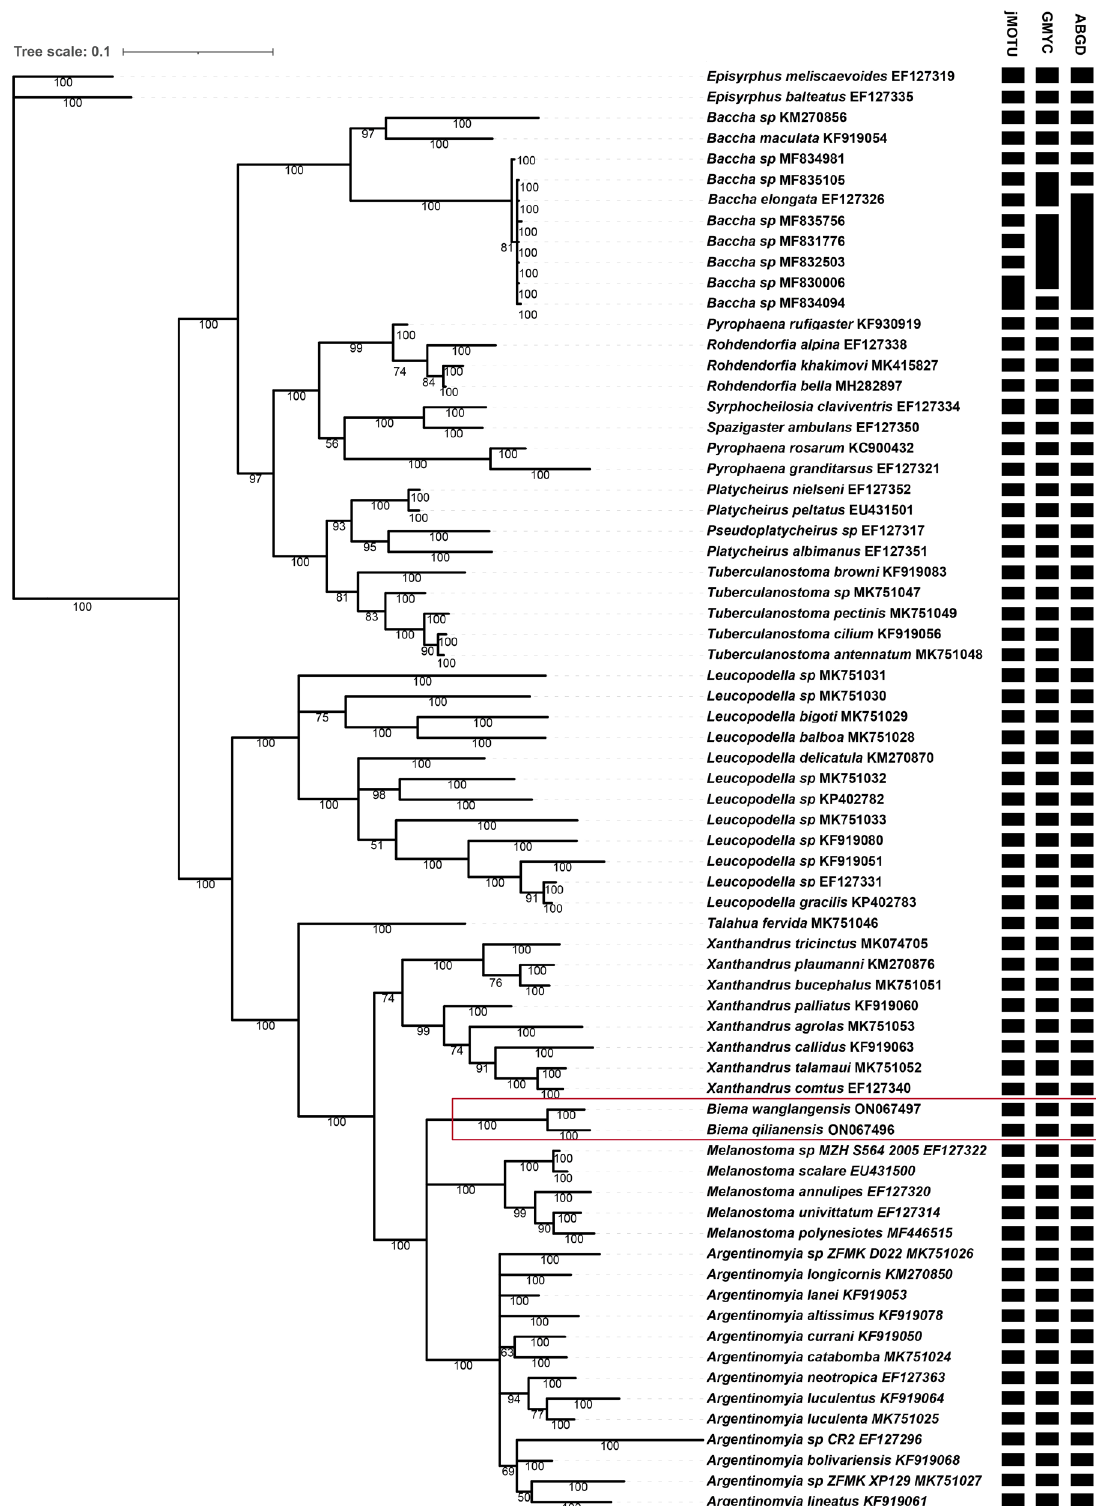
Fig. 43. The phylogenetic tree of the tribes Bacchini Bigot, 1883 and Melanostomini Williston, 1885 based on the COI gene. Statistical support values (posterior probability) of BI methods are shown above each node. Groups resulting from jMOTU, GMYC and ABGD tests are indicated on the right